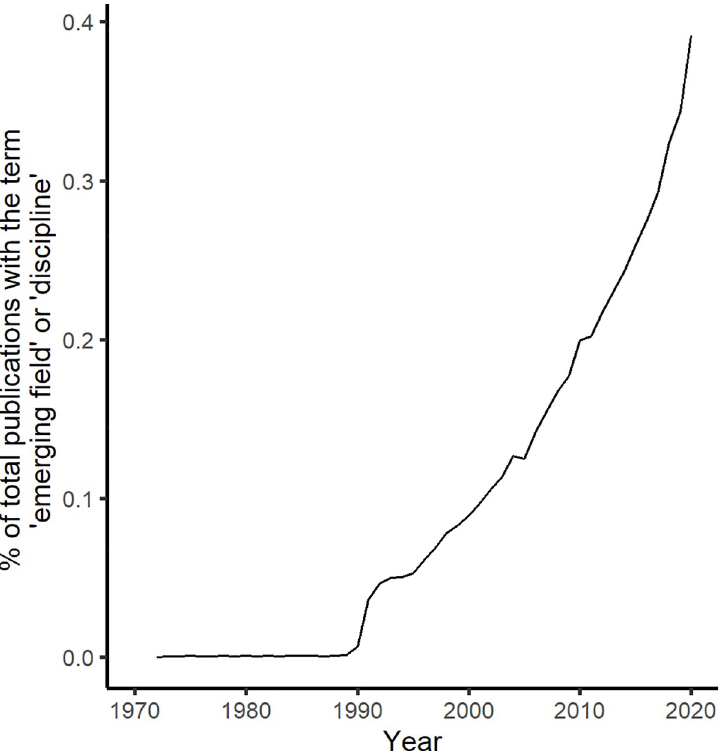
Fig 1. The percent of publications that use the term “emerging field” or “emerging discipline” out of the total publications published in Web of Science from 1970 to 2020.